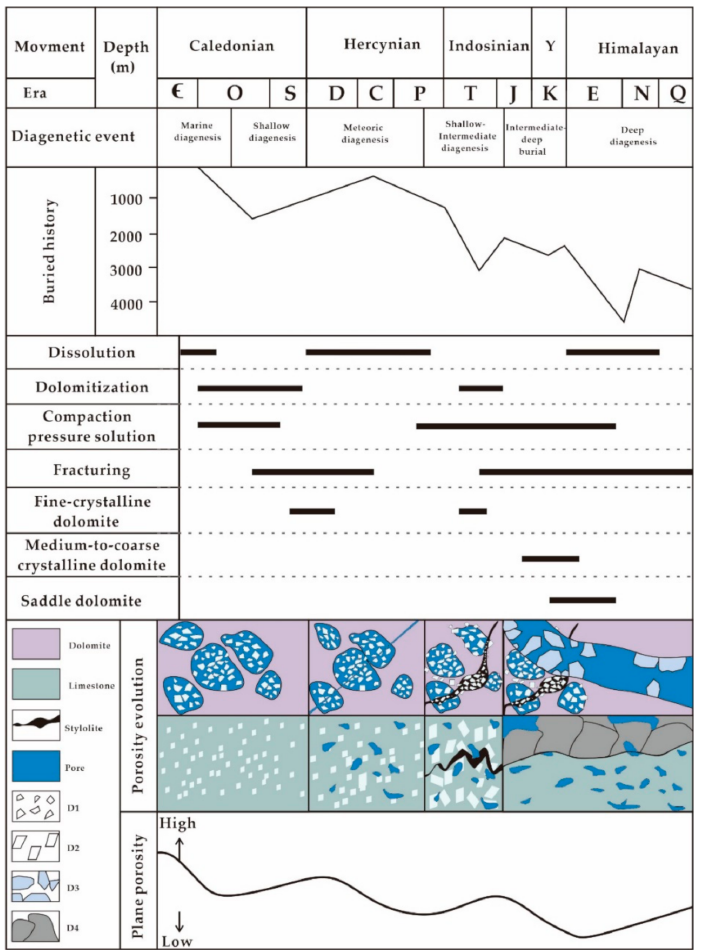
Figure 11. Diagenetic events and pore evolution of dolomite reservoir of the Lower Paleozoic strata in the Dongying Depression, Bohai Bay basin. Y represents Yanshan movement; D1: powder-to-fine- crystalline dolomite cements; D2: fine-crystalline dolomite cements; D3: medium-to-coarse-crystalline dolomite cements; D4: saddle